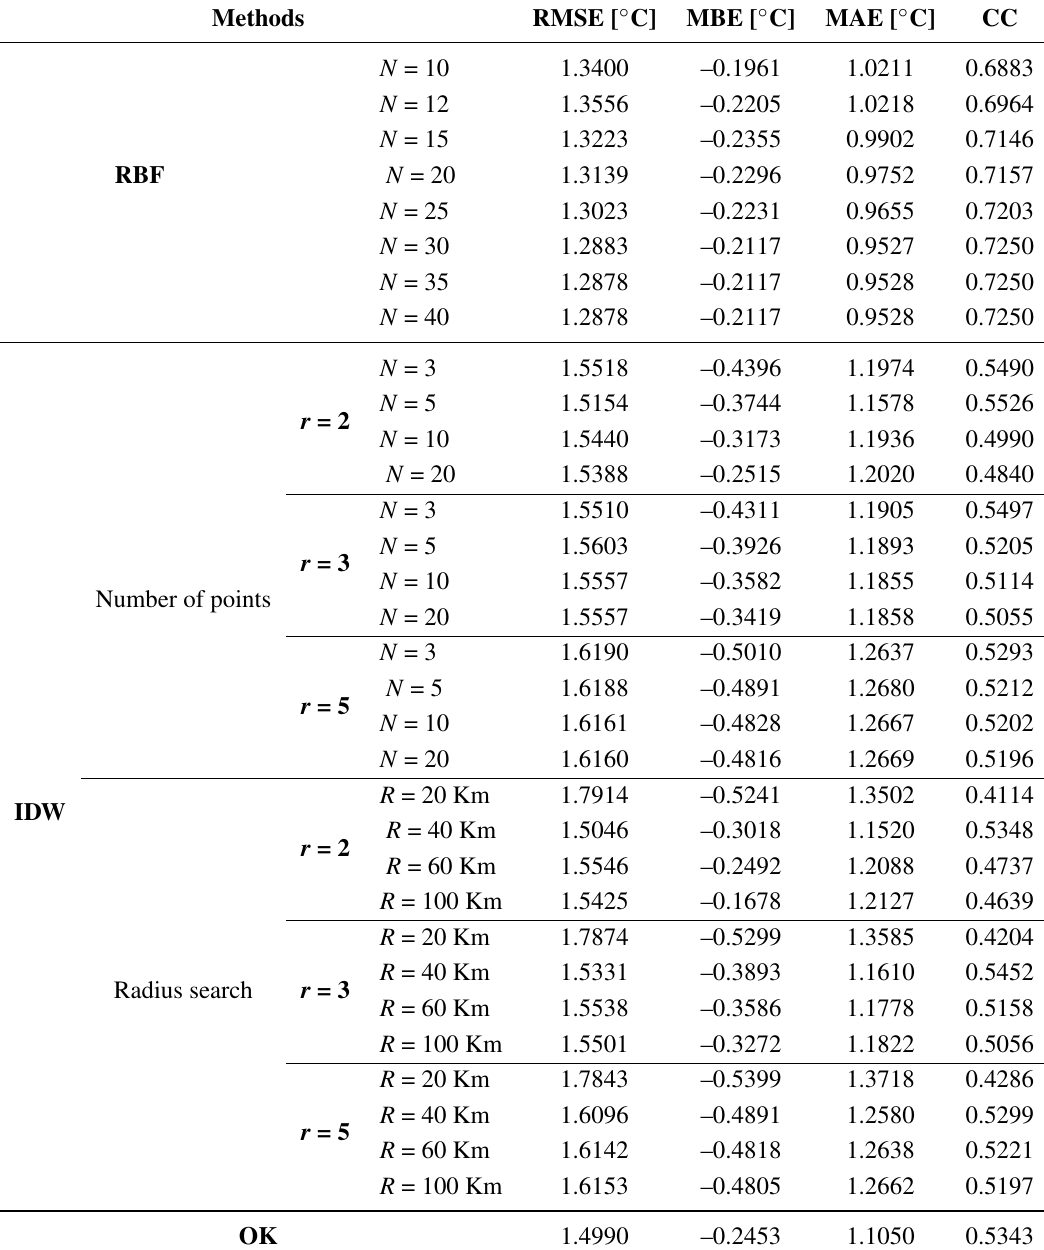
Table 1. Comparison of goodness of interpolation for the univariate methods applied to mean annual